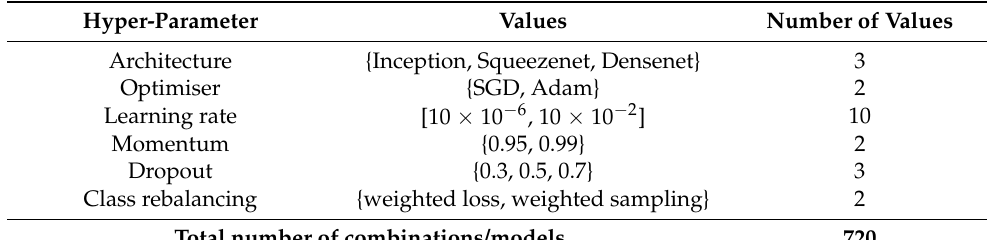
Table 2. Hyper-parameters explored in the grid search.